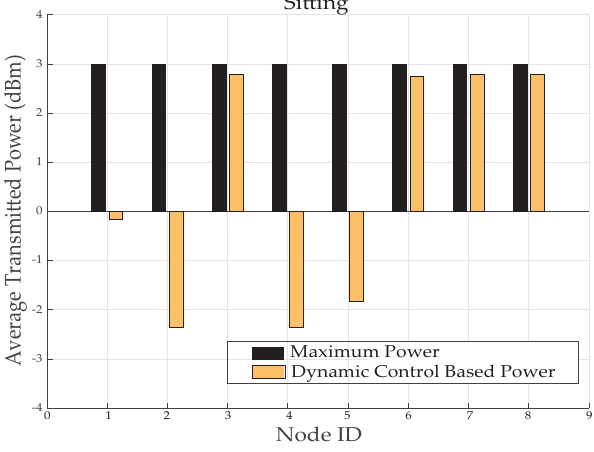
Figure 21. Average TX power consumption while sitting